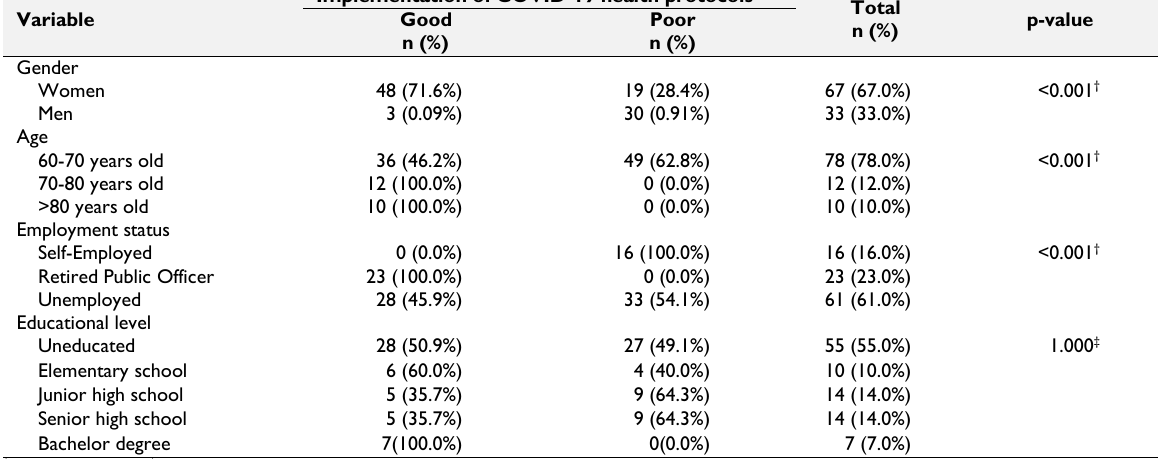
Table 2 Bivariate correlation between gender, age, profession and education on implementation of COVID-19 health protocols (n = 100) Implementation of COVID-19 health Variable